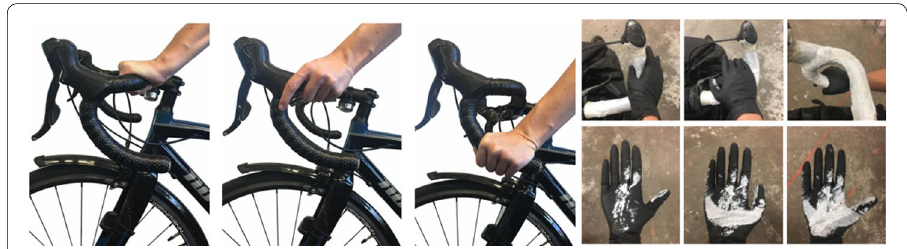
Fig. 12 Road cyclist user needs (Sokolowski and Hoegsted